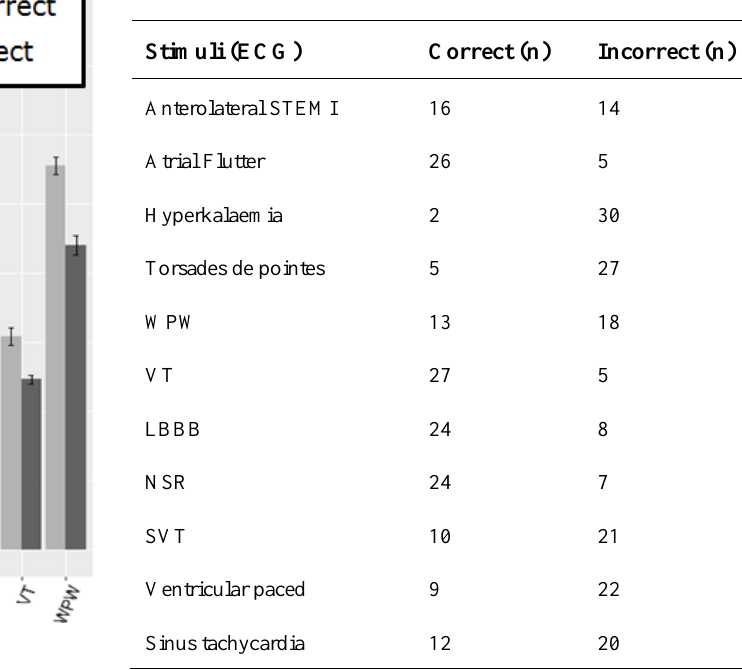
Table 2. The number of participants making correct and incorrect interpretations per ECG.